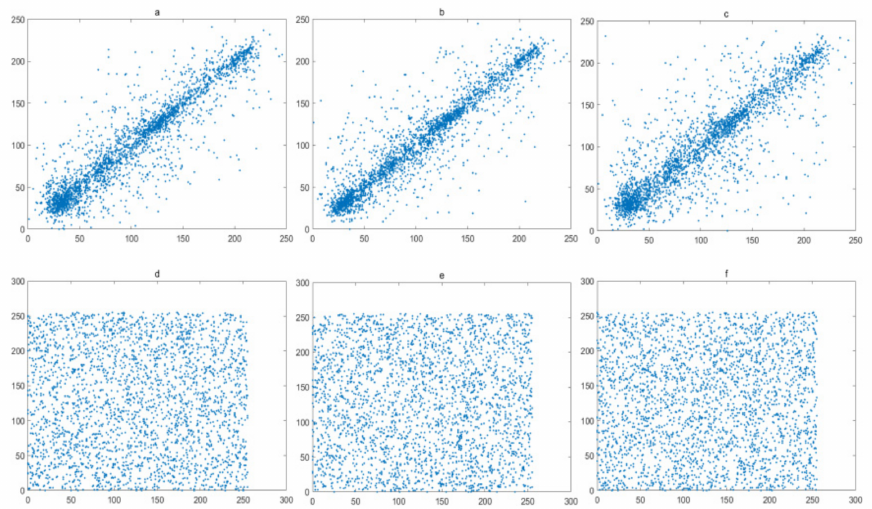
Figure 16. Correlation analysis of Lena image: ( a – c ) horizontal, vertical and diagonal direction of plain-text image; ( d – f ) horizontal, vertical and diagonal direction of cipher.